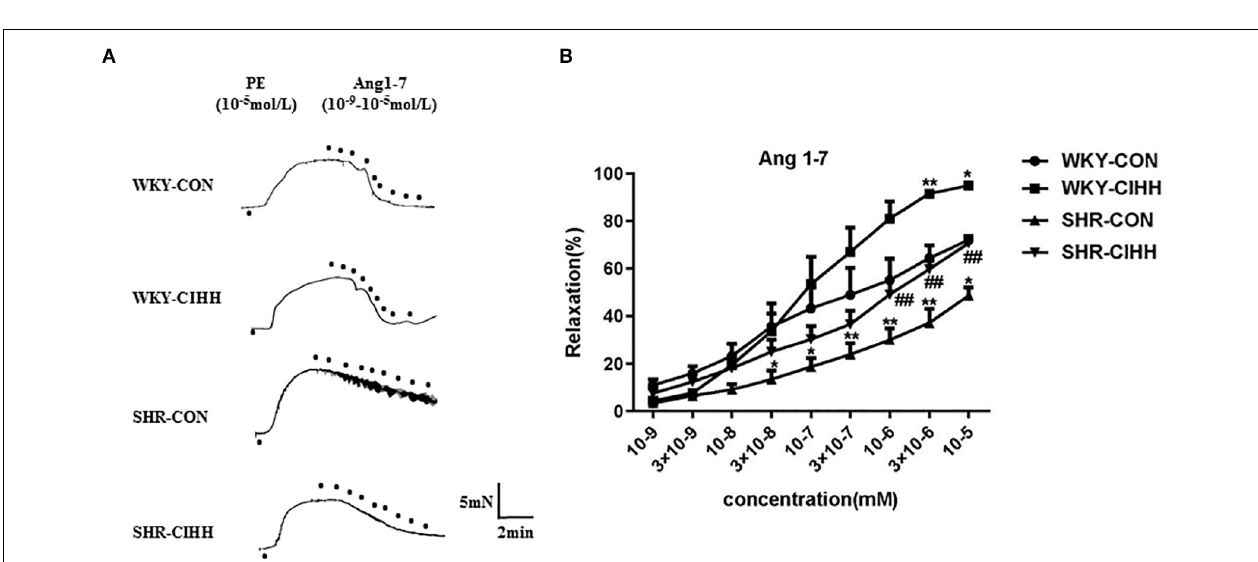
FIGURE 7 | Effect of chronic intermittent hypobaric hypoxia (CIHH) on Ang 1–7-induced relaxation in mesenteric artery of spontaneously hypertensive rat (SHR). Representative traces (A) and summarized data (B) of mesenteric arteries in response to different concentrations of Ang 1–7 after precontracted with PE. Data are expressed as mean ± SEM; SHR-CON: control SHR ( n = 16); SHR-CIHH: SHR with CIHH ( n = 14); WKY-CON: control WKY rats ( n = 12); WKY-CIHH: WKY rats with CIHH ( n = 12). * P < 0.05, ** P < 0.01 vs. WKY-CON, ## P < 0.01 vs. SHR-CON (two-way